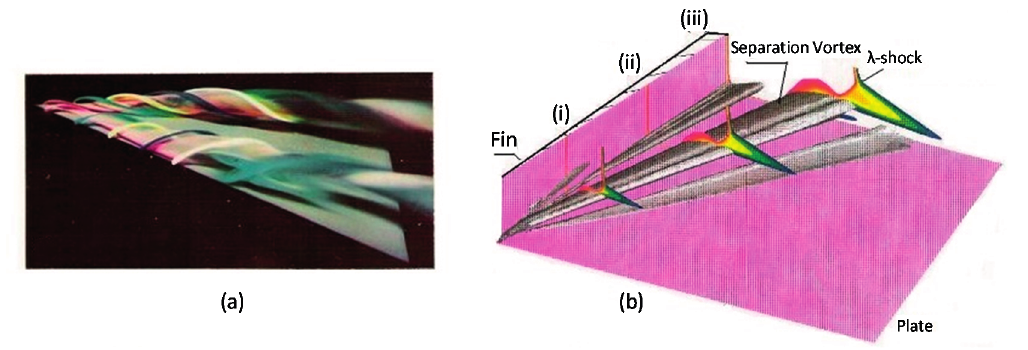
Figure 1. Formation of extensive crossflow separation: ( a ) Delta wing at high-incidence flow. Picture taken by H. Werle (ONERA) in a water-tank; ( b ) Swept shock/boundary layer interaction in a fin/plate configuration. The quasi-conical separation vortex is visualized by the contours of the eigenvalues of the velocity gradient field